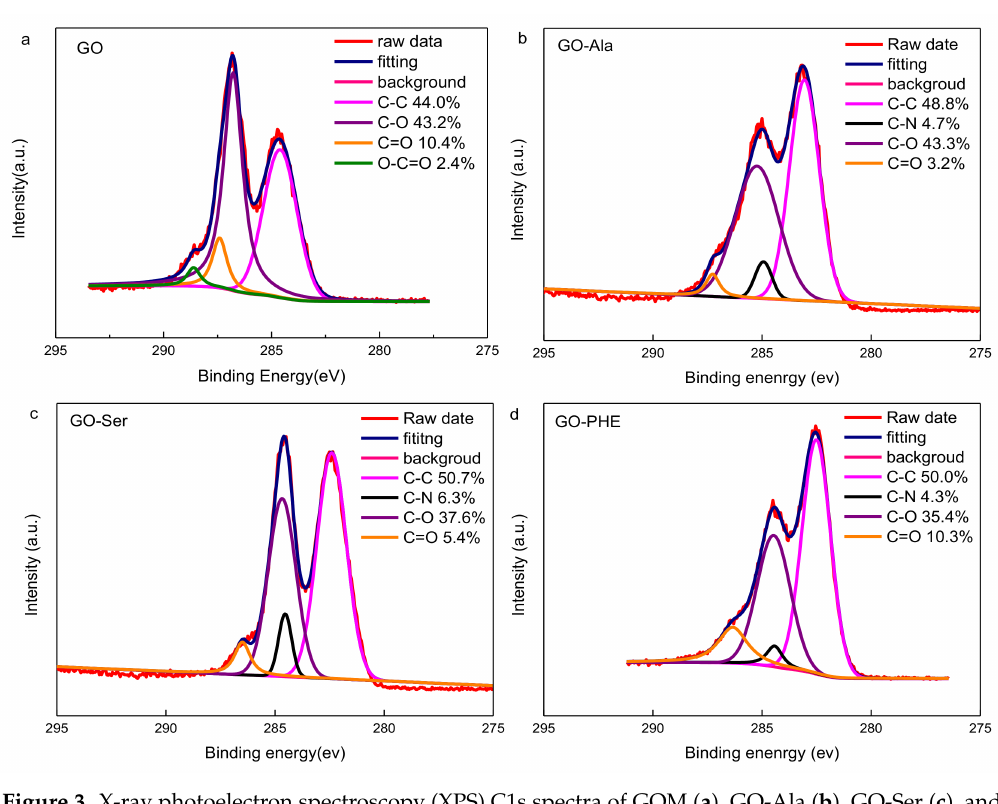
Figure 3. X-ray photoelectron spectroscopy (XPS) C1s spectra of GOM ( a ), GO-Ala ( b ), GO-Ser ( c ), and GO-PHE ( d ).